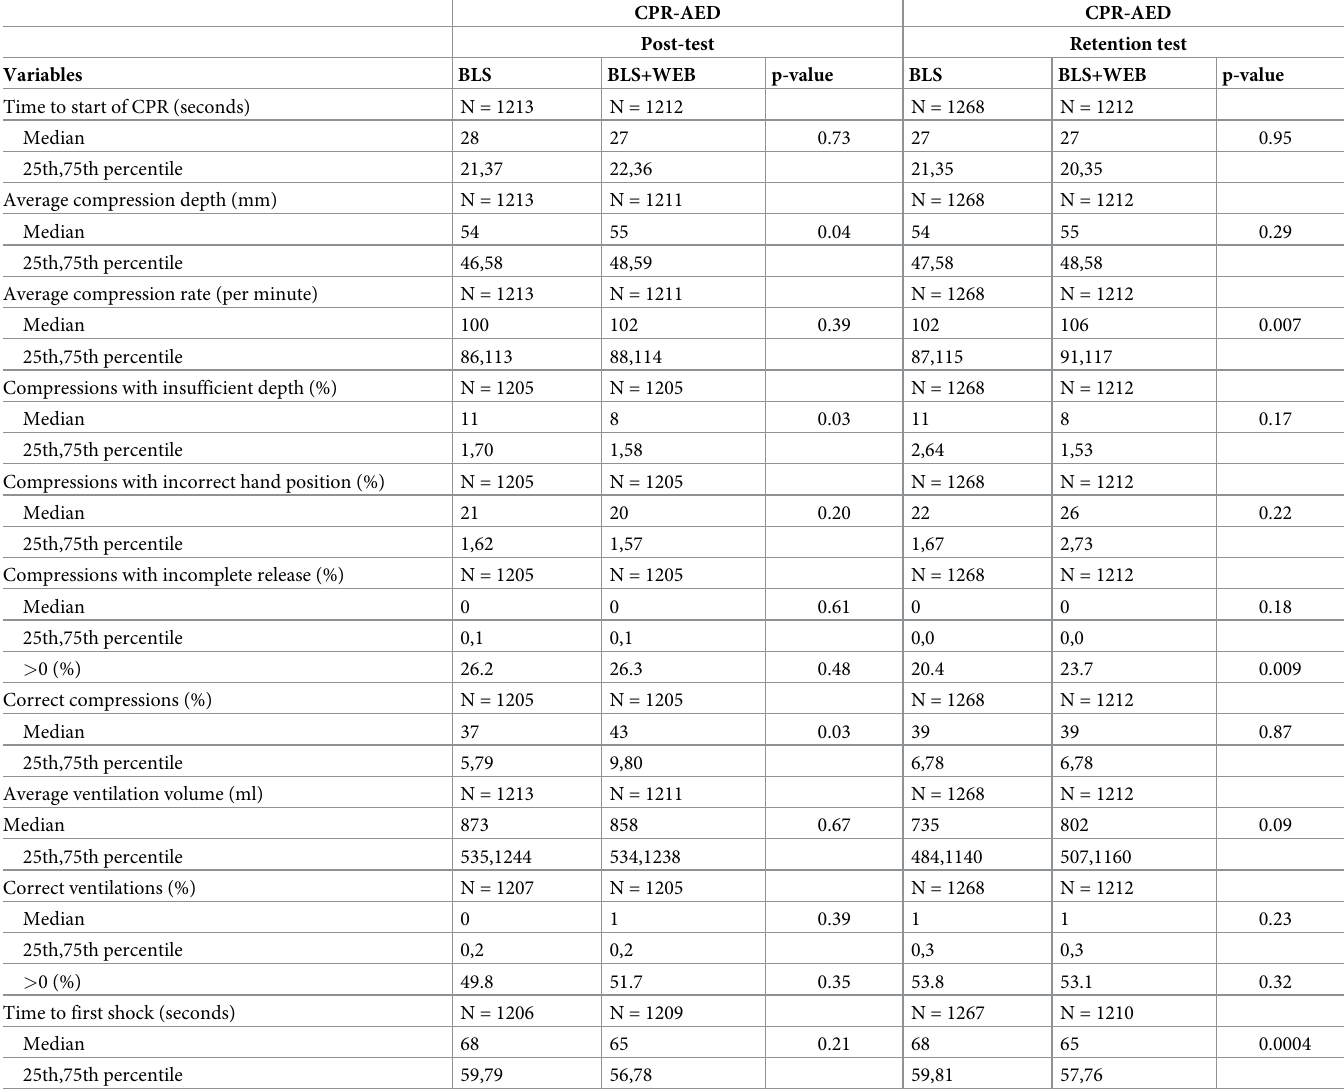
Table 3. Separate variables for quality of practical skills for cardiopulmonary resuscitation and automated external defibrillation